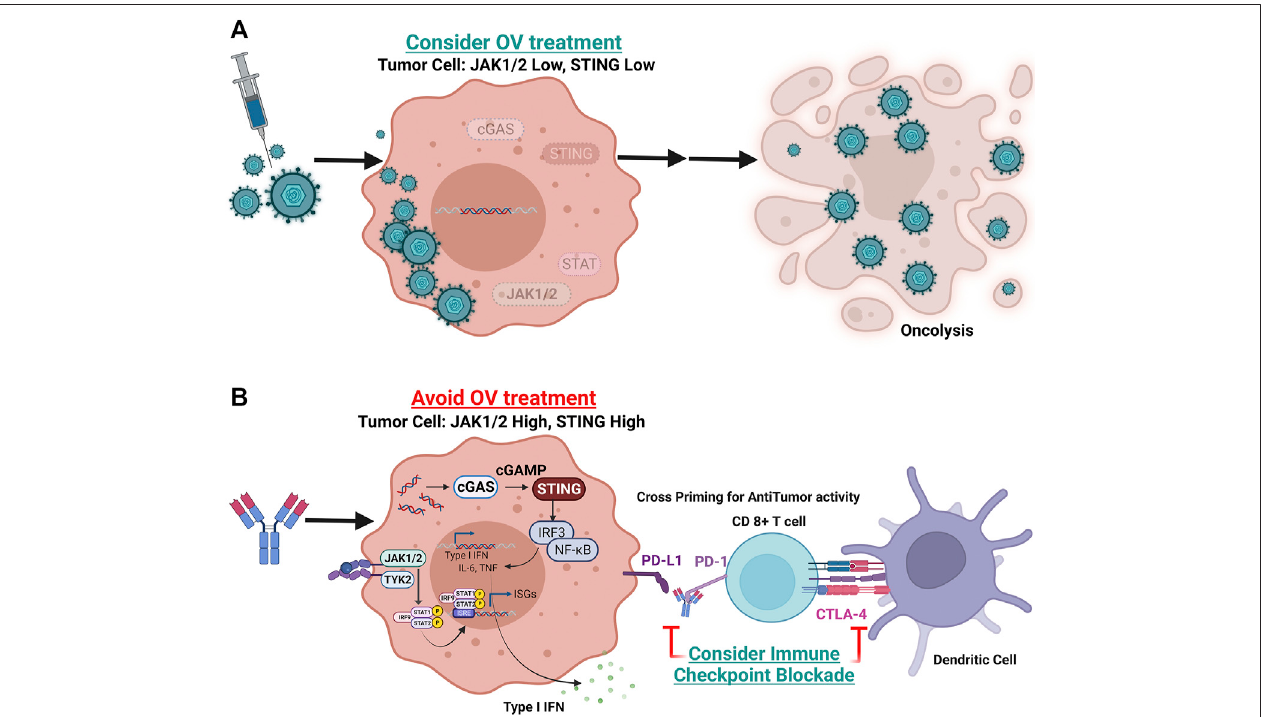
FIGURE 2 | Potential predictive biomarker strategy for oncolytic virus therapeutic response. Shown are tumor cells with variable gene expression and interferon pathwaysignalingstatusatthetimeofinitialdiagnosisorpre-treatmentbiopsy. (A) TumorcellwithlossoffunctionorlowlevelsofJAK1,JAK2,and/orSTINGexpression. In these tumors, oncolytic viruses may replicate more ef fi ciently and induce widespread immunogenic cell death (oncolysis). (B) Tumor cells with intact JAK1, JAK2 and STING signaling will be resistant to DNA viral replication but are more sensitive to immune checkpoint blockade. These tumor cells will express higher levels of PD- L1 making them permissive to PD-1 blockade and potentially other checkpoint blockade, such as CTLA-4 (Created with Biorender).